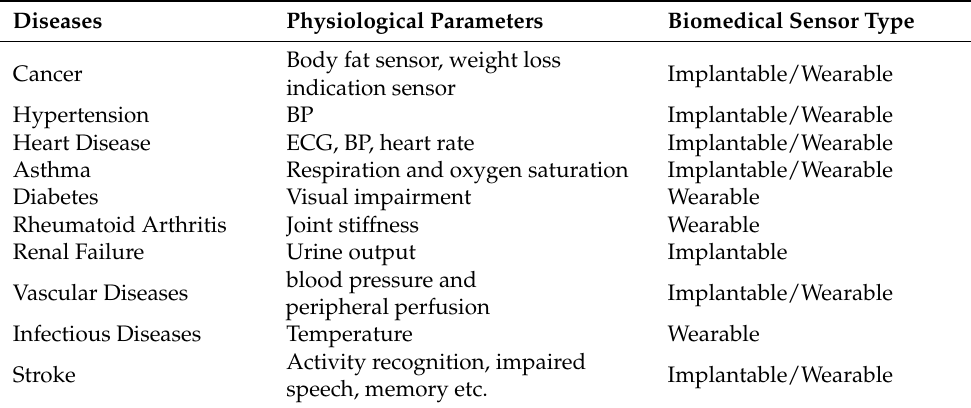
Table 3. Chronic monitoring diseases with usable sensor types.